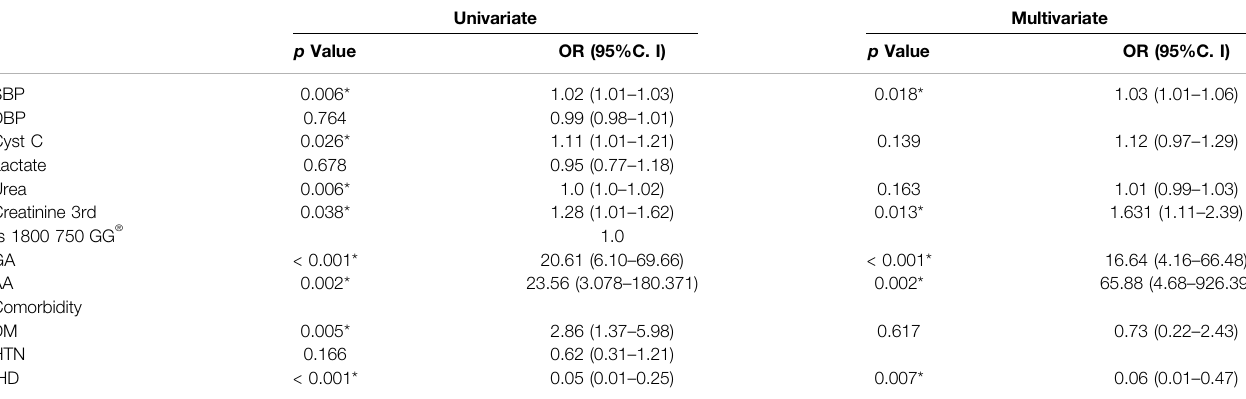
TABLE 5 | Univariate and multivariate Logistic regression analysis for S-AKI for different parameters in total patients (No. (cid:1) 200). Univariate Multivariate